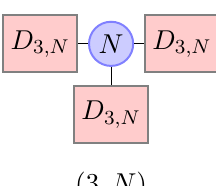
Figure 2 . Our main theory of interest, (3 , 2) , has N = 2 and is the simplest member of this larger class of theories (see figure 1). More generally, we may consider exactly marginal diagonal SU( N ) gaugings of three D 3 (SU( N )) := D 3 ,N SCFTs (where D 3 , 2 := D 3 ). The only constraint on N is that gcd(3 , N ) = 1